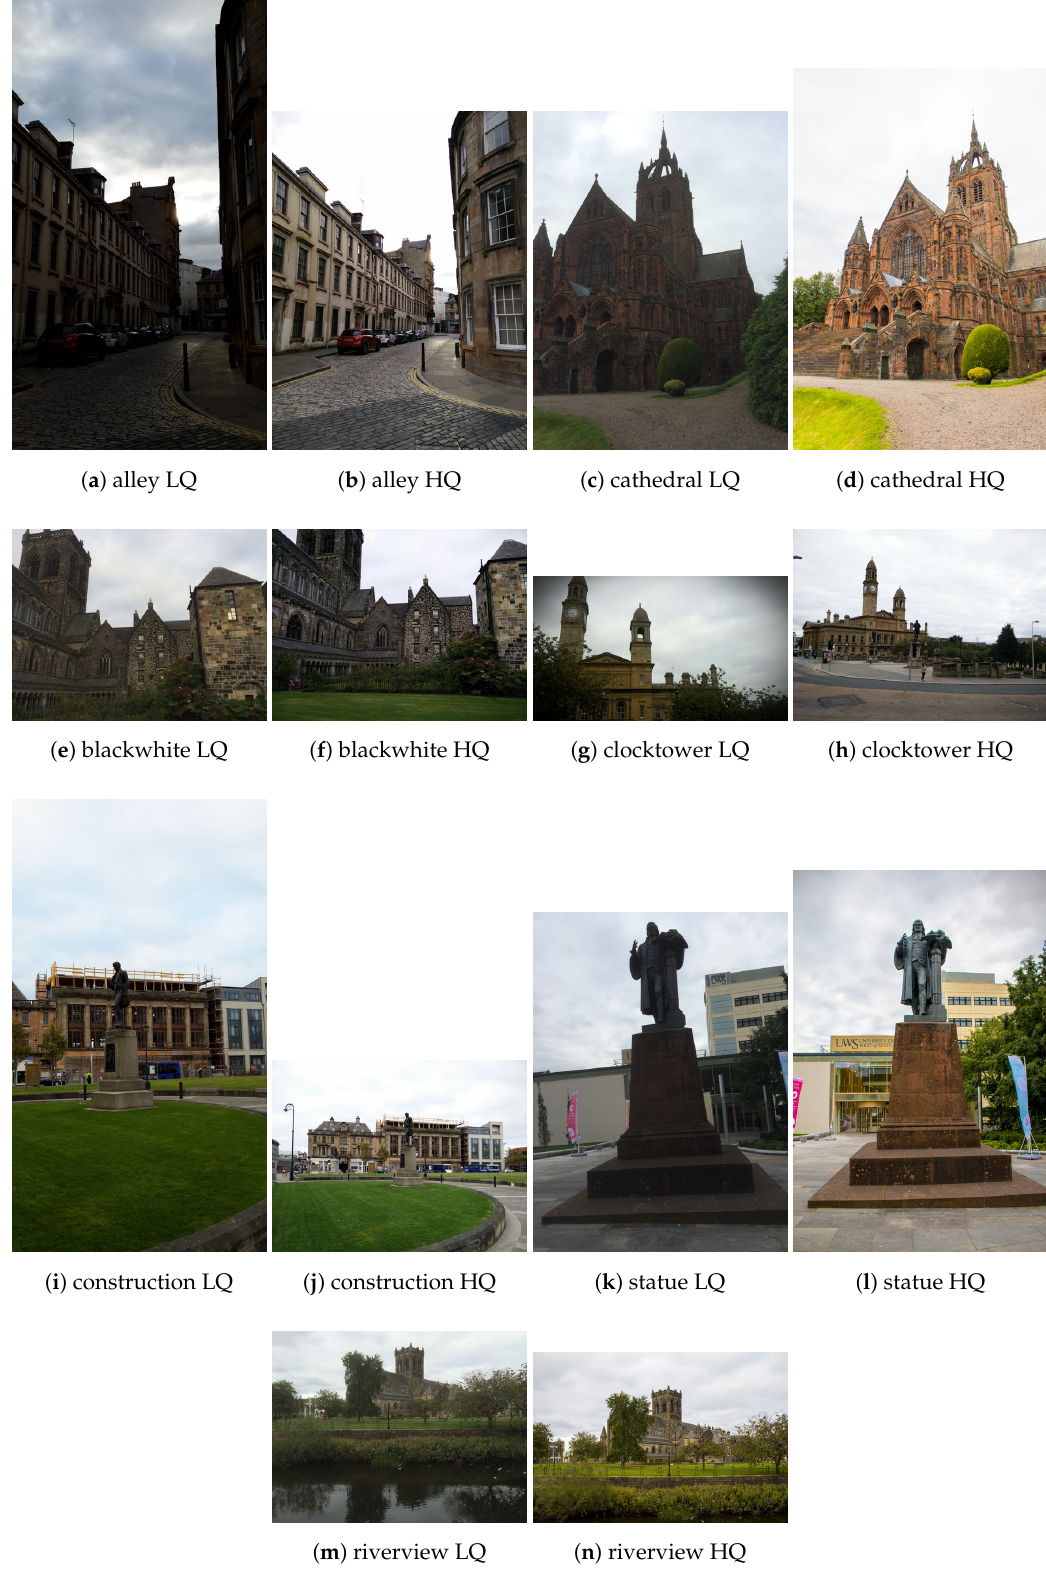
Figure 2. Samples of the VIME1 scenes with Low Quality (LQ) and High Quality